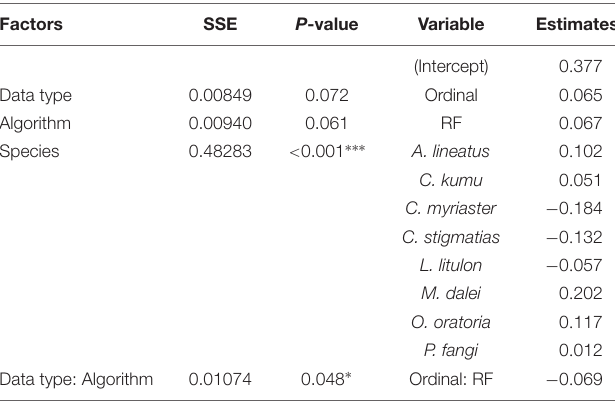
TABLE 4 | The effects of data type, algorithm and species on performance metric (weighted Kappa) for predictions on abundance grades by